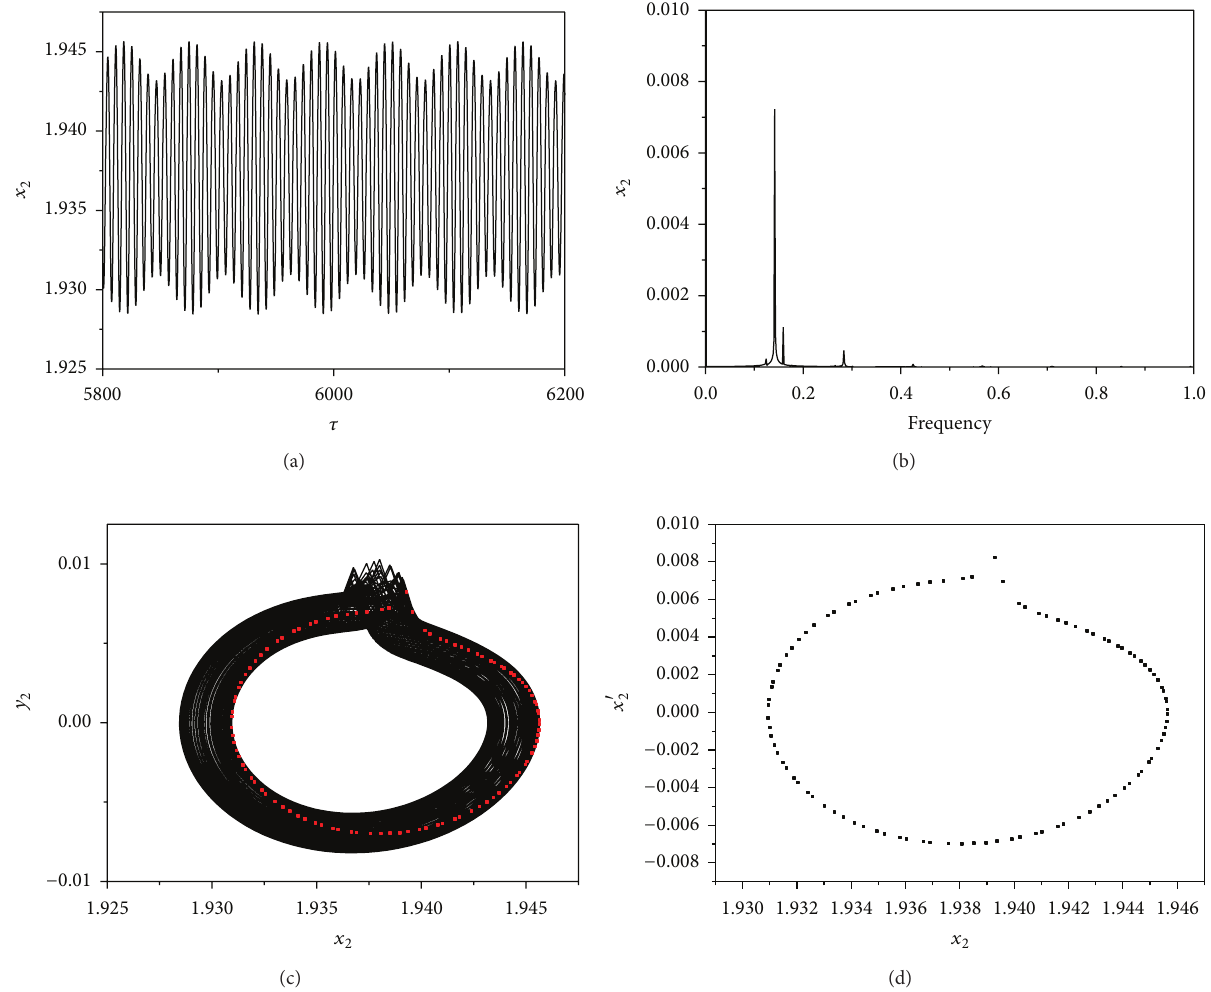
Figure 22: See 𝜔 = 0.650 . (a) Displacement response. (b) Frequency spectrum. (c) Phase-portrait plots. (d) Poincar´e